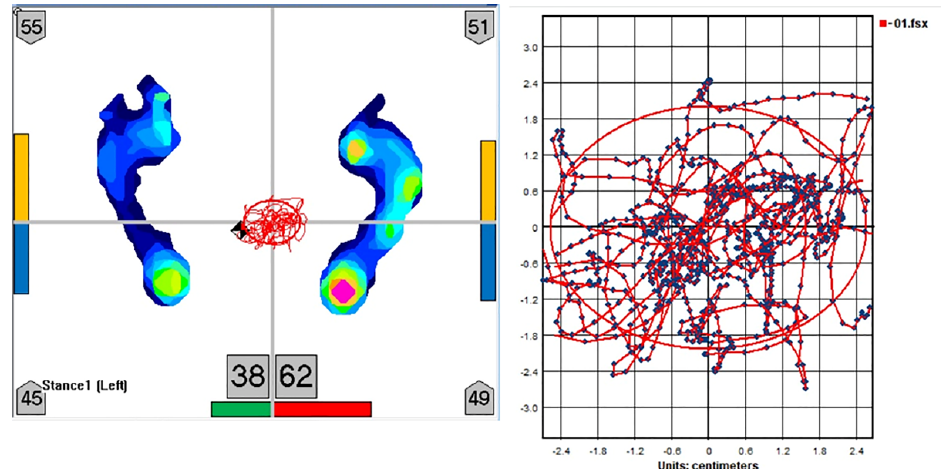
Figure 2. Center of pressure trajectories in the horizontal plane of a representative subject with Parkinson’s disease.